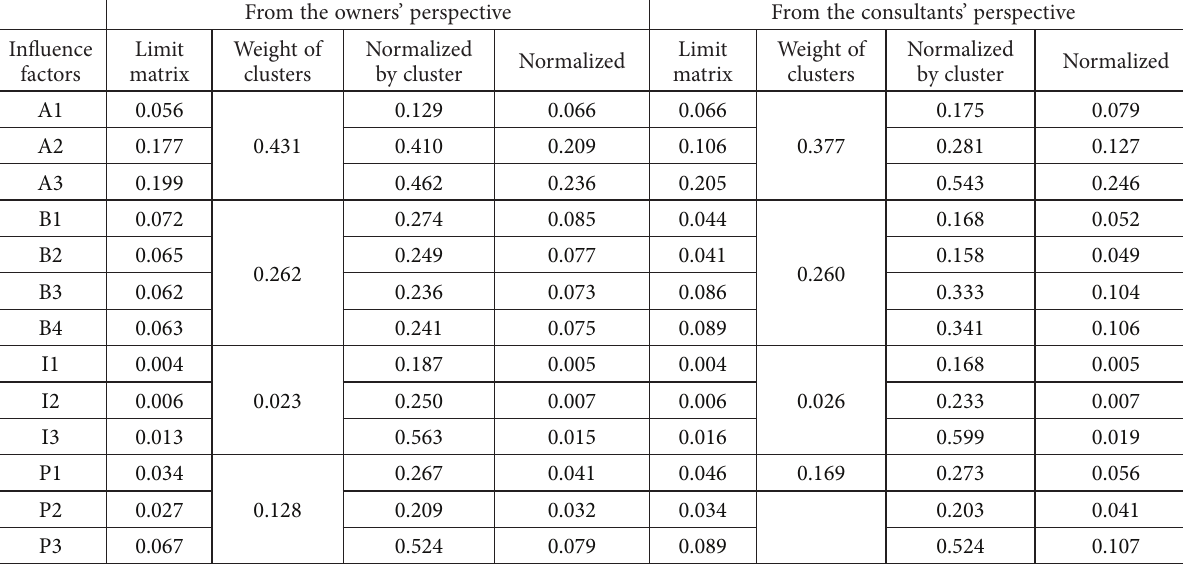
Table 5. Final priorities of the factors that influence the development of trust for owners and